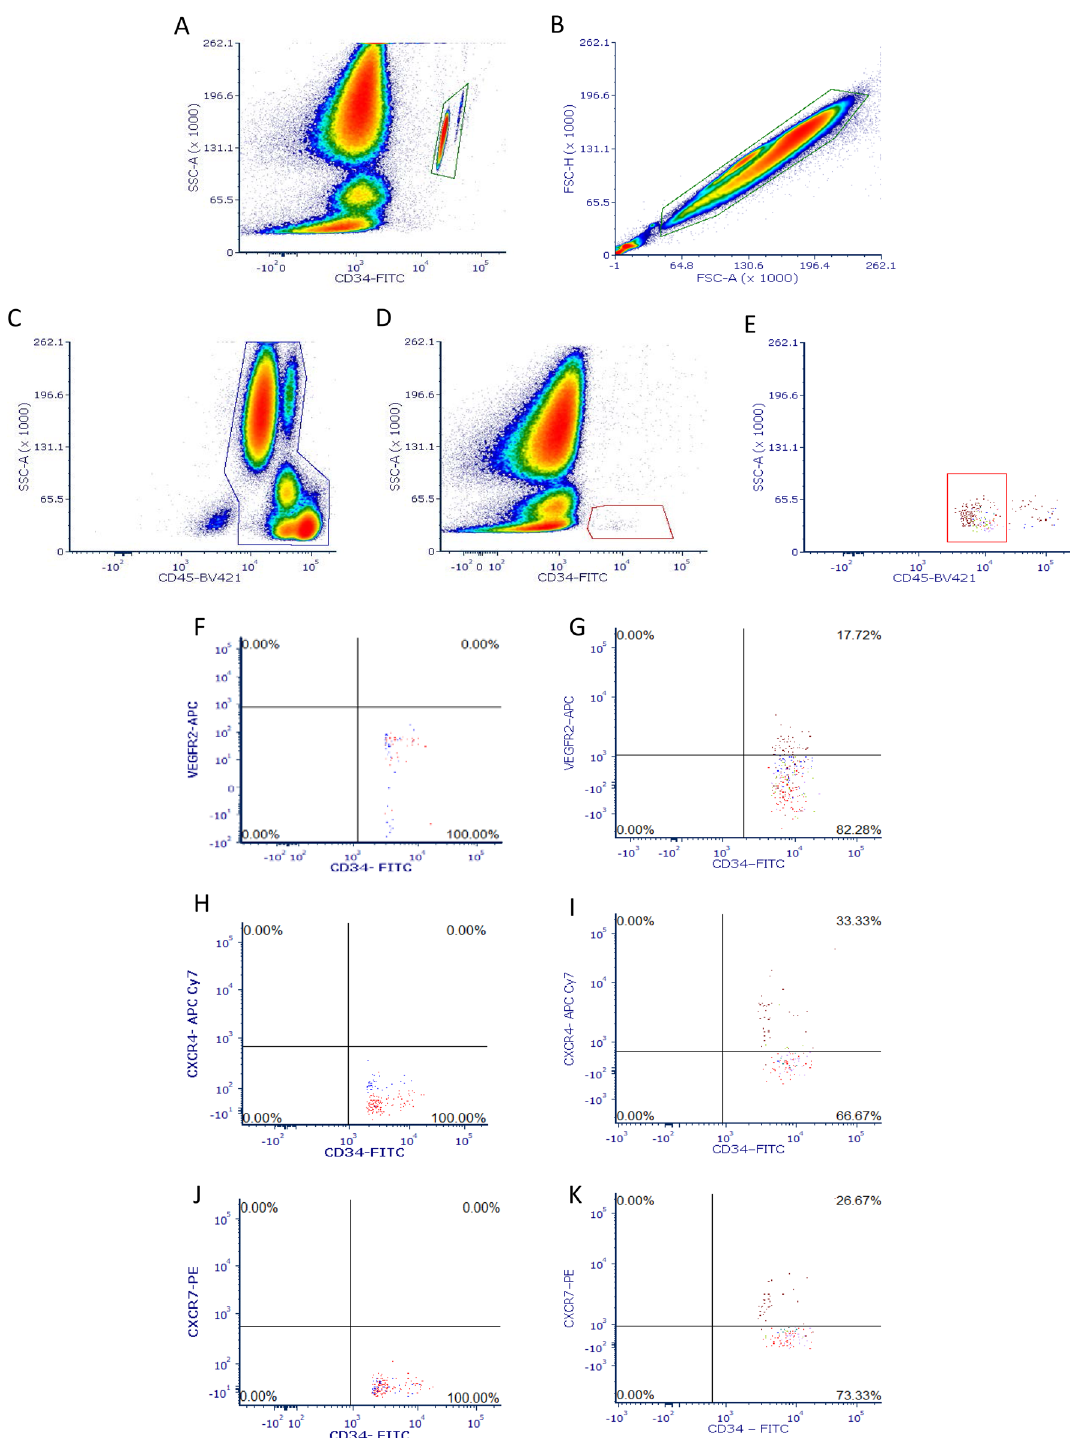
Figure 1. Enumeration of HCPs and EPCs by flow cytometry. ( A ) Gating of the fluorescent beads from the Trucount Tubes to determine absolute cell count. ( B ) Forward scatter height versus forward scatter area density plot for gating doublet exclusion. ( C ) Gating of CD45 + mononuclear cells. ( D ) Identification of CD45 + cells expressing CD34 + with low side scatter (CD34 + cells). ( E ) Gating of low expression of CD45 + (CD34 + CD45 dim cells). ( F ) Negative controls for the identification the gating of positive VEGFR2 + events. ( G ) Identification of VEGFR2 + on CD34 + or CD34 + CD45 dim cells. ( H ) Negative controls for the identification the gating of positive CXCR4 events. ( I ) Identification of CXCR4 cell surface expression upon all HPC and EPCs phenotypes. ( J ) Negative controls for the identification the gating of positive CXCR7 events. ( K ) Identification of CXCR7 cell surface expression upon all HPC and EPCs